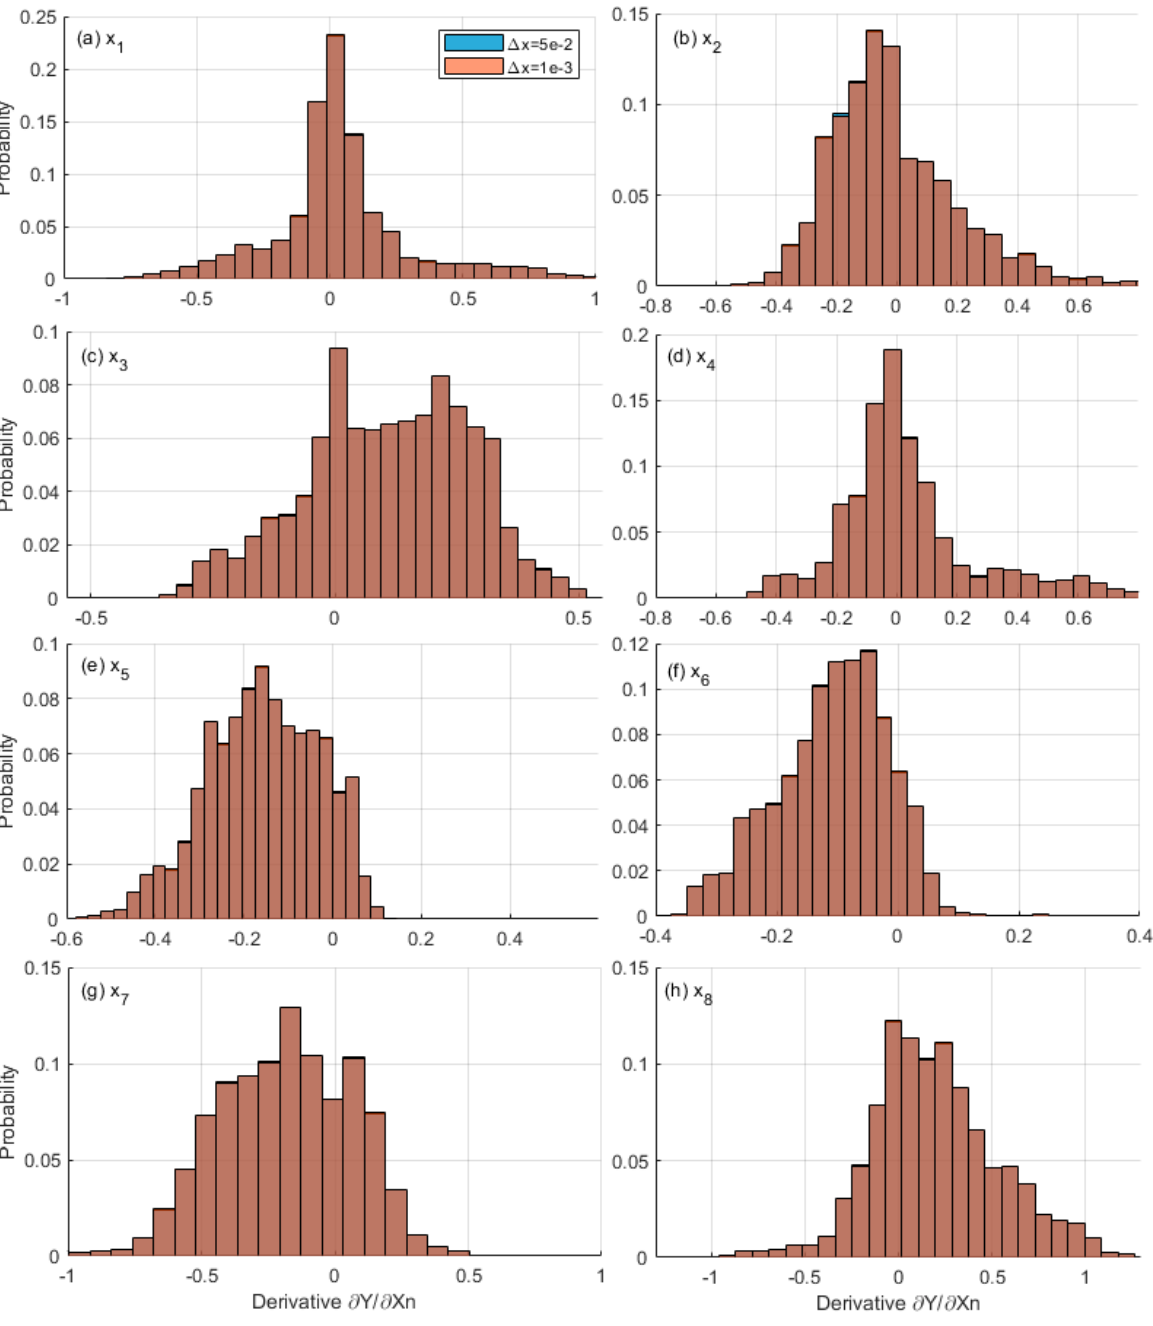
Figure 8. Histogram of partial derivatives for the total dataset based on MOD2 (the optimized LSSVM model). Each partial derivative is evaluated numerically with a small or large difference Δ𝑥 .